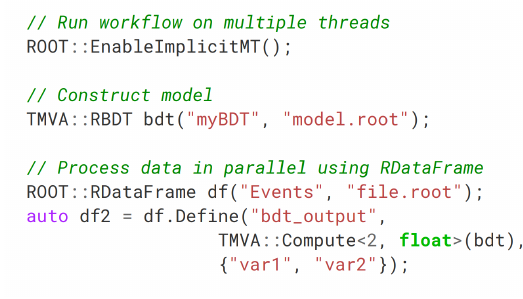
The feature is in an experimental stage and available with the ROOT release